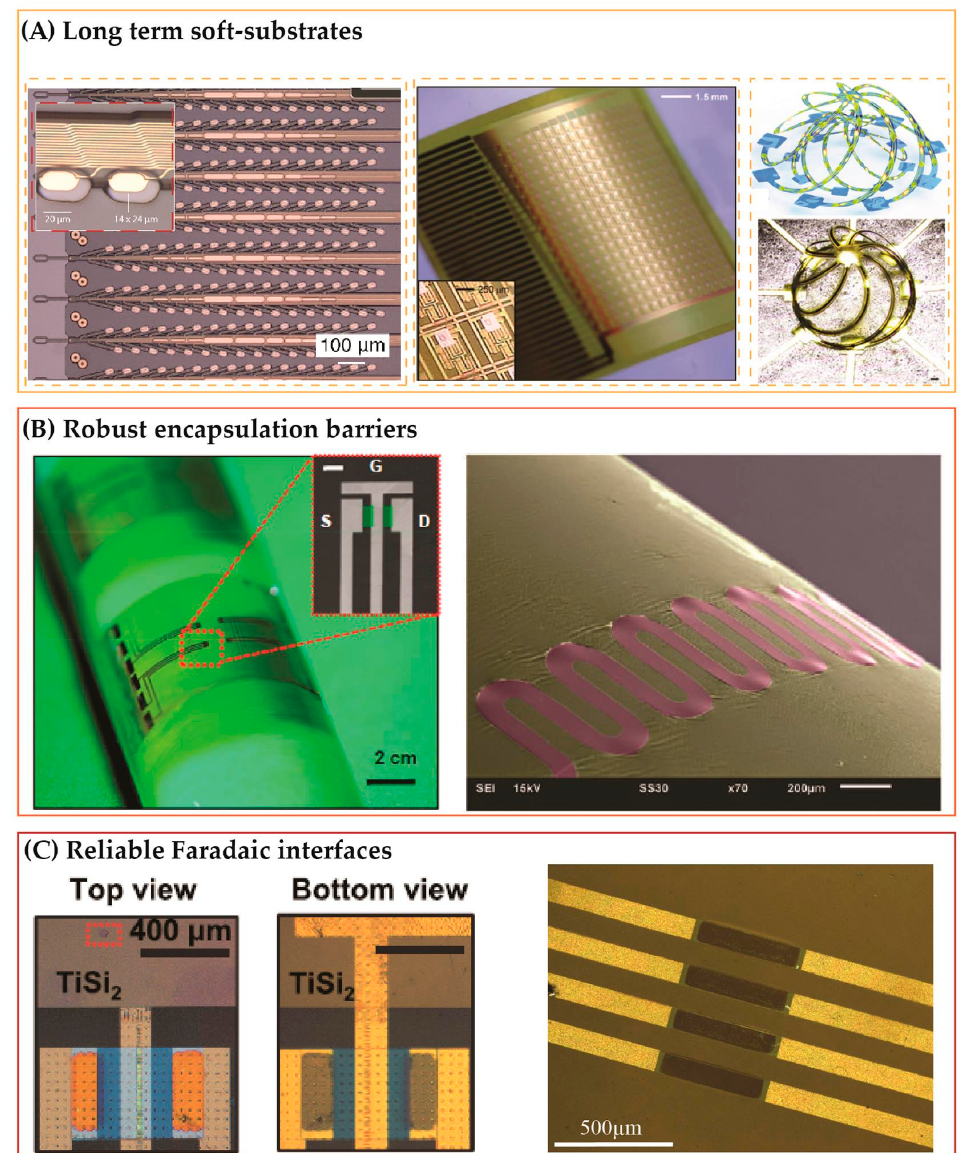
Figure 2. Long-lived electronics are constructed by materials that can tolerate to biofluidic corrosion and ion diffusion. ( A ) Stable soft substrate using polyimide. From left to right: Photograph of tree-probe configuration, [37] array of TFTs on a bendable polyimide film, [39] 3D polyimide structures as a scaffold for cell growth [40]. ( B ) Bio-barriers. Left: tri-layer of parylene-C/HfO 2 /SiO 2 [41]. Right: A stretchable SiC membrane [42]. ( C ) Faradaic interfaces for recording and stimulation. Left: Si/TiS 2 electrodes [43]. Right: Highly doped transferred SiC resistors [44].